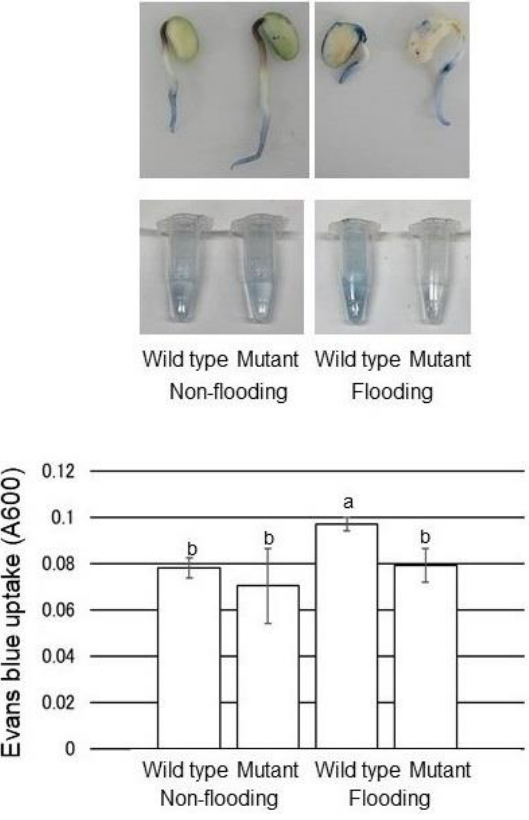
Figure 6. Evaluation of cell death in soybean with Evans-blue staining. After flooding, soybean seedlings were stained with Evans-blue dye. The Evans-blue dye was extracted from the root tip and absorbance was measured at 600 nm. Data are shown as means ± SD from 3 independent biological replicates. The different letters indicate significant changes according to one-way ANOVA followed by Tukey’s multiple comparisons ( p < 0.05).